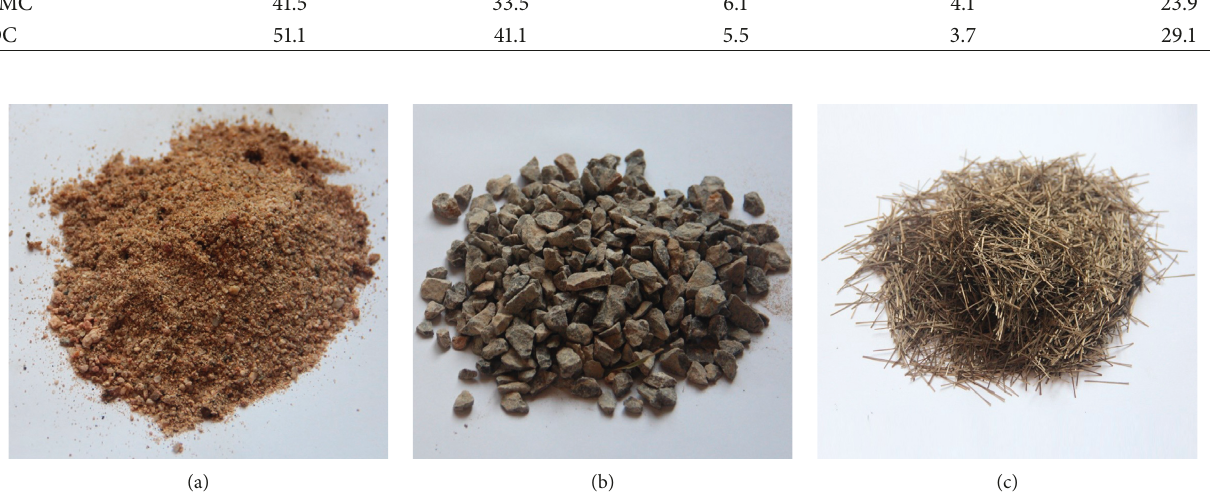
Figure 12: Photos of sand, aggregate, and basalt fiber used in concrete. (a) Sand. (b) Aggregate. (c) Basalt fiber.